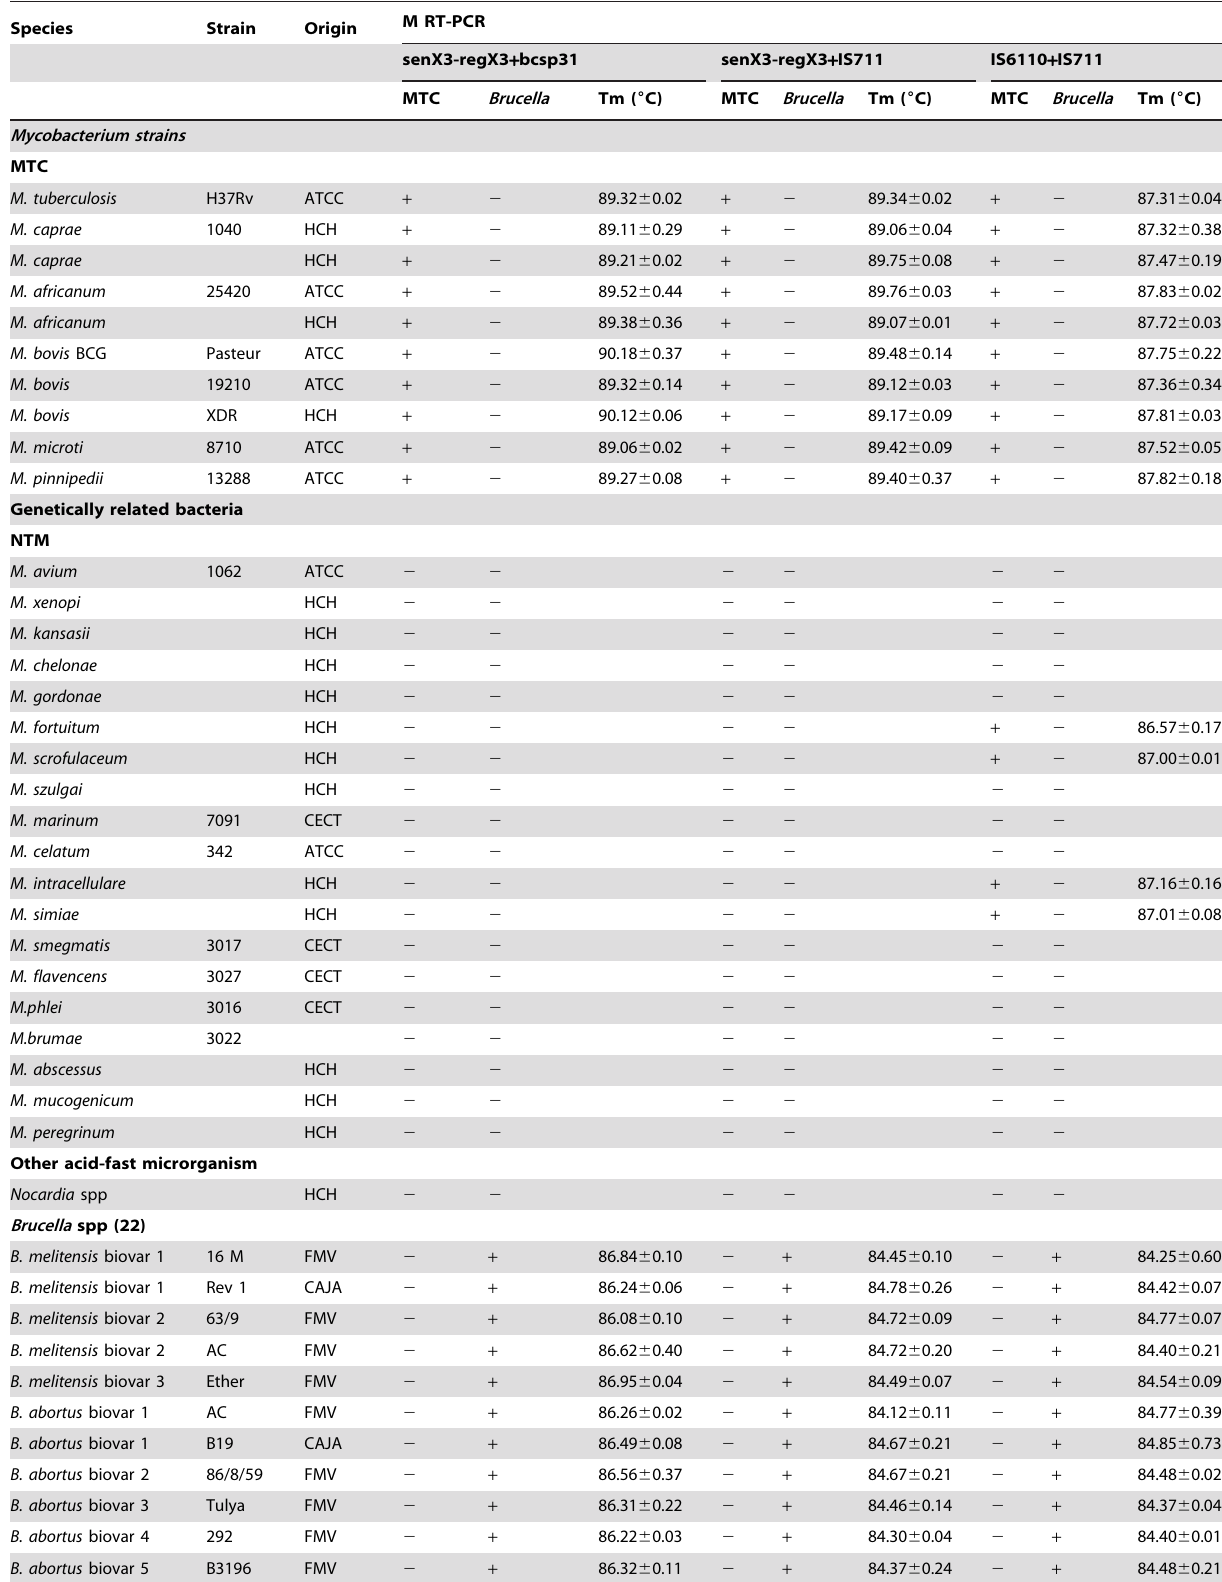
Table 1. M RT-PCR results with DNA from different microorganism included in this study.